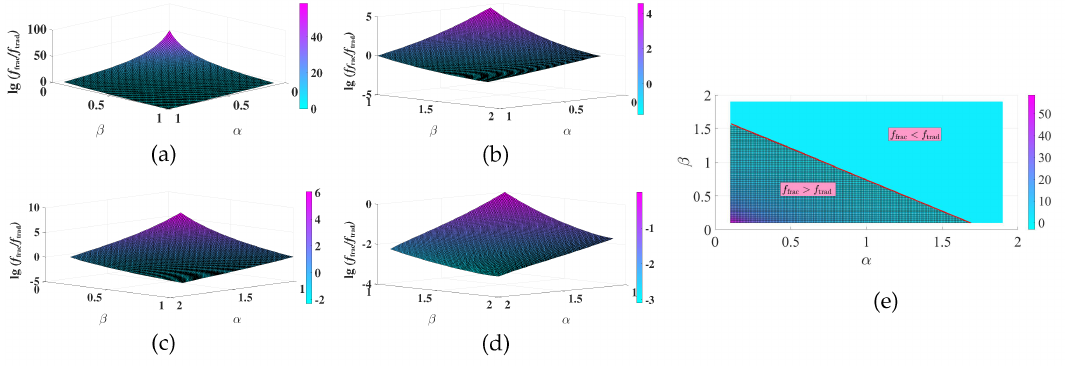
: Variations of 0 < α < 2 and 0 < β < 2. In detail, Figure 7. Relationship curves among α , β , and lg f frac f trad sub-figures demonstrate the details of 3D plots of ( a ) 0 < α < 1,0 < β < 1, ( b ) 0 < α < 1,1 < β <